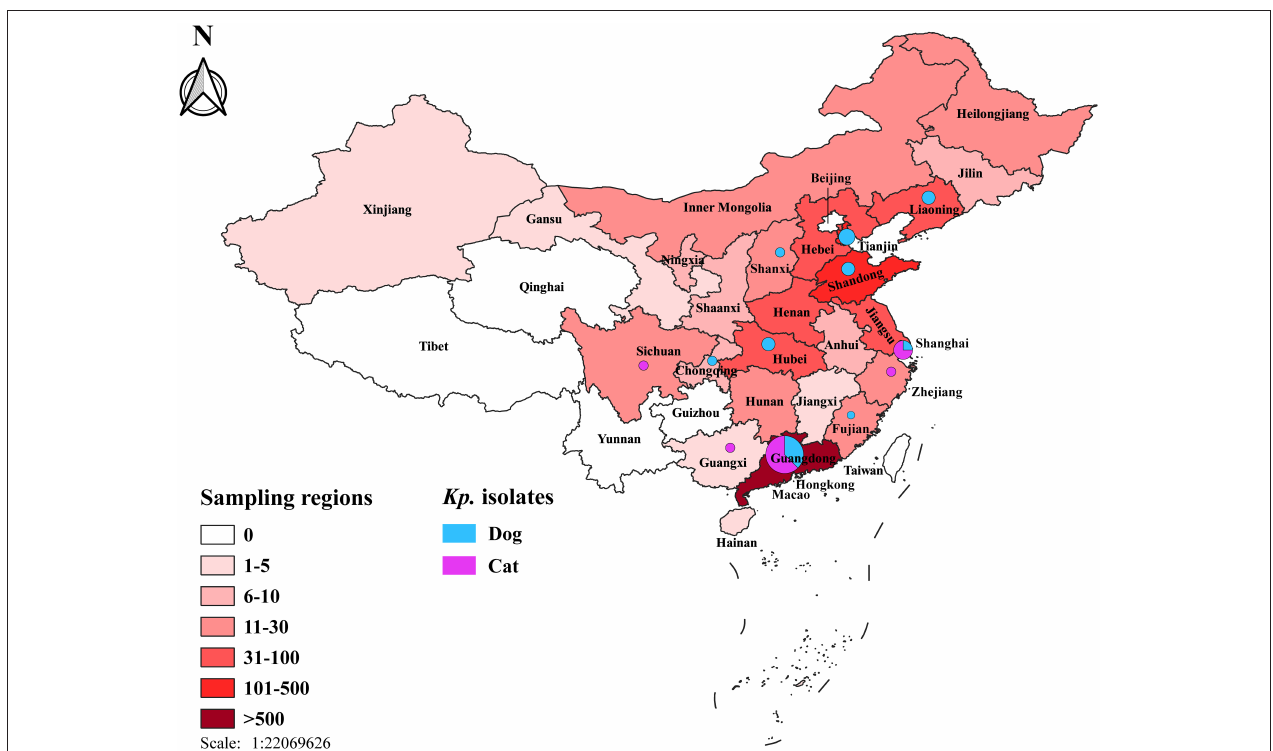
FIGURE 1 | Map of the sampling locations and the prevalence of K. pneumoniae complex isolates among dogs and cats in the 26 regions across China. The color gradation stands for the number of samples in different regions. Numbers and the percentages of K. pneumoniae complex were demonstrated using isometric pie